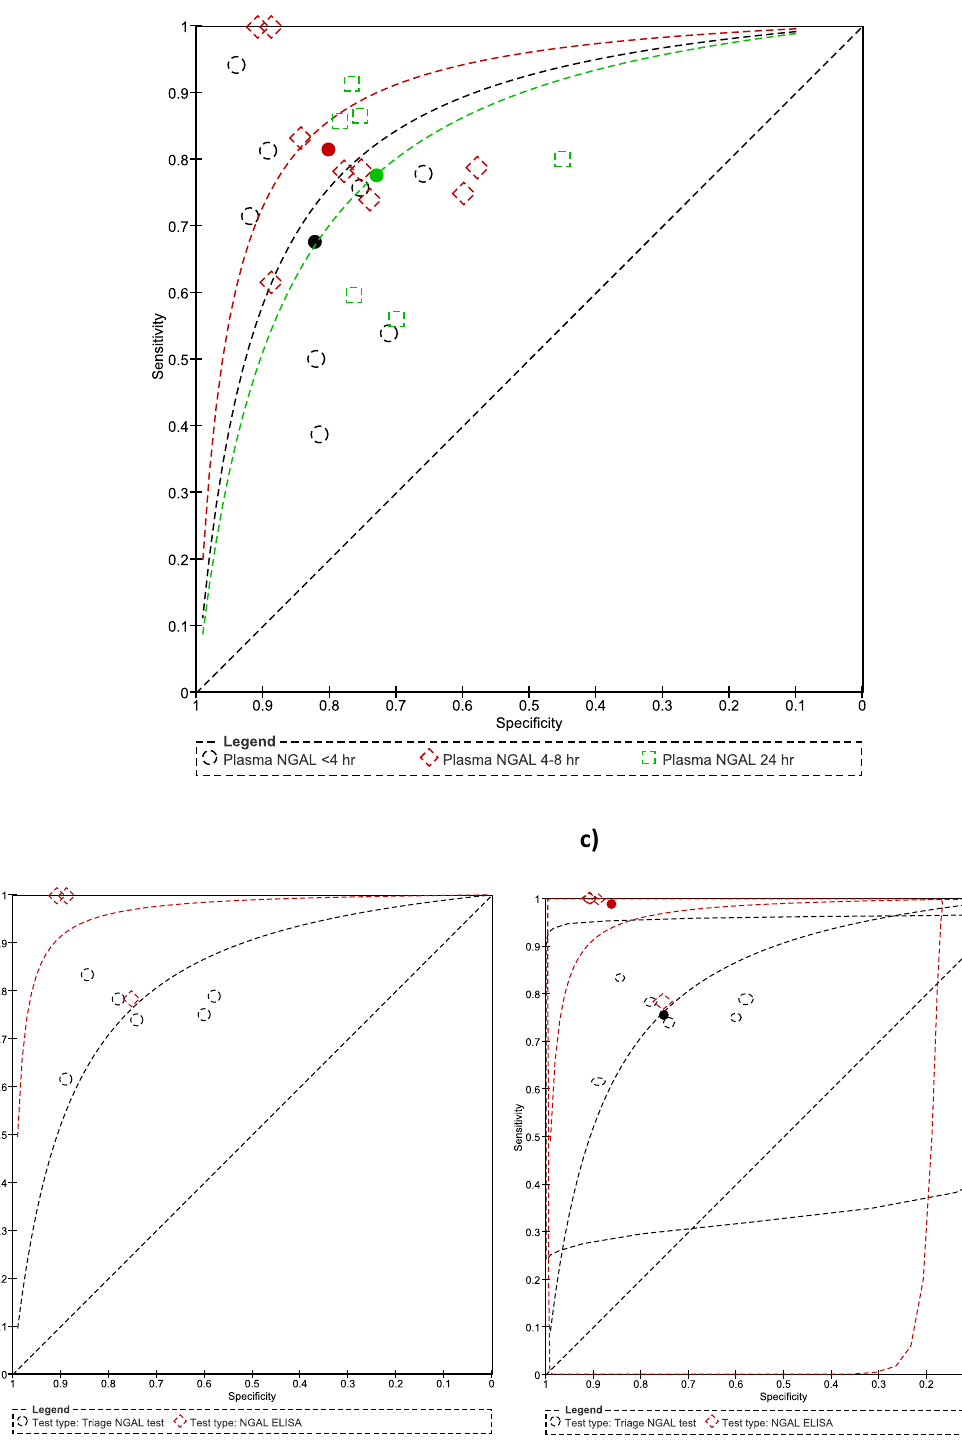
Figure 5. ( a ) Summary ROC plots with hSROC summary points overlaid, ( b ) summary ROC when method type was added as a covariate, ( c ) summary ROC when method type was added as a covariate with hSROC summary points and prediction regions